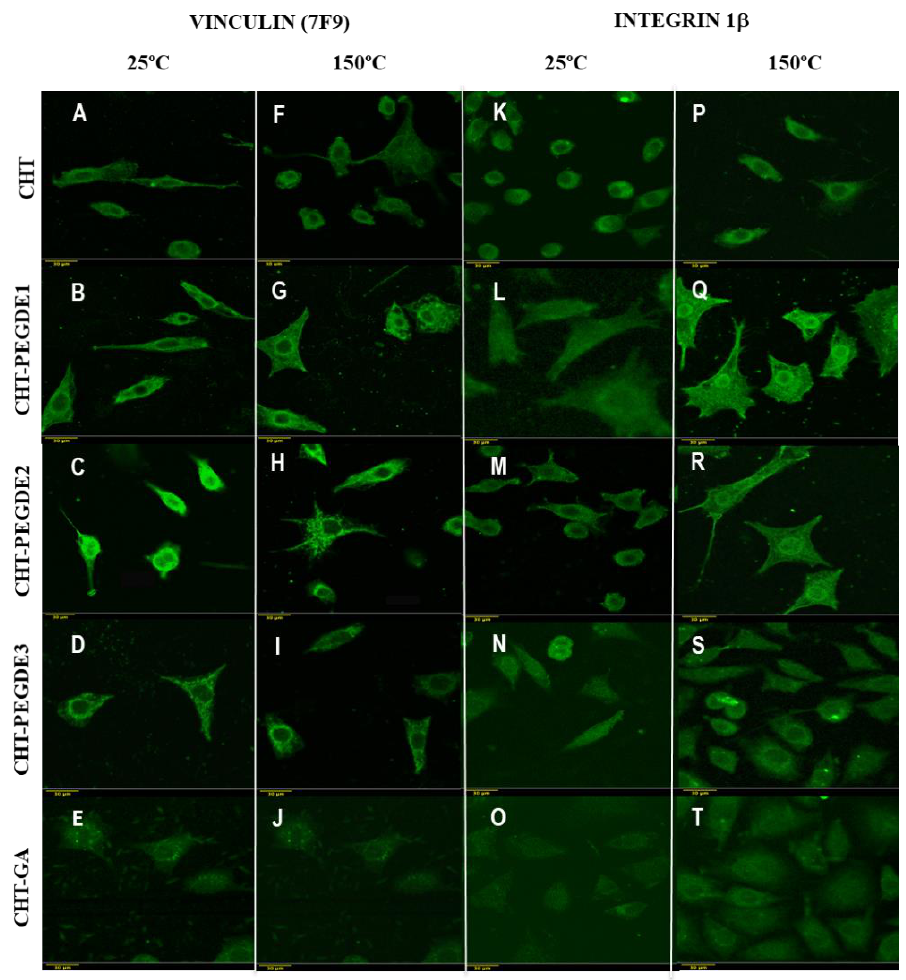
Figure 8. ( A – J ) Fluorescence images of osteoblast seeded onto CHT sca ff olds labeled with vinculin Figure 8. (A–J) Fluorescence images of osteoblast seeded onto CHT scaffolds labeled with vinculin (7F9): sc-73614, cultivated for 48 h. ( K – T ) Fluorescence images of osteoblast seeded onto CHT sca ff olds (7 F 9): sc- 73614 , cultivated for 48 h. (K–T) Fluorescence images of osteoblast seeded onto CHT labeled with intregrin 1 β (A-4), cultivated for 48 scaffolds labeled with intregrin 1  ( A- 4) , cultivated for 48 h.